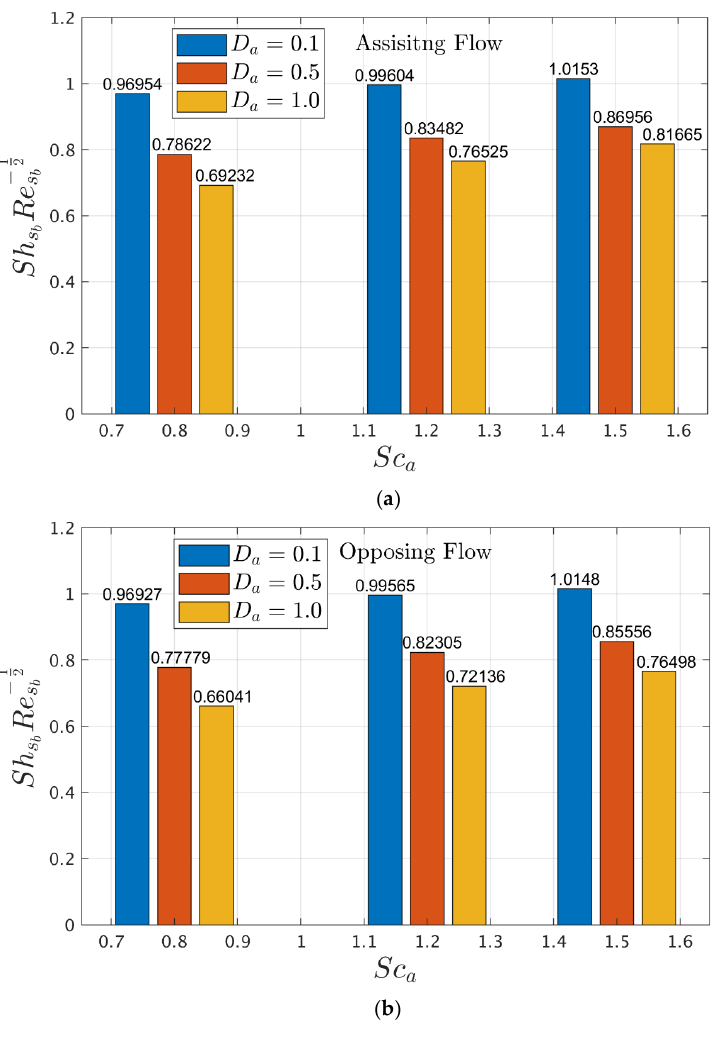
Figure 13. The bar graph represents the mass transfer against a S c for the case of ( a ) assisting flow and ( b ) opposing flow with various values of the curvature parameter radius.